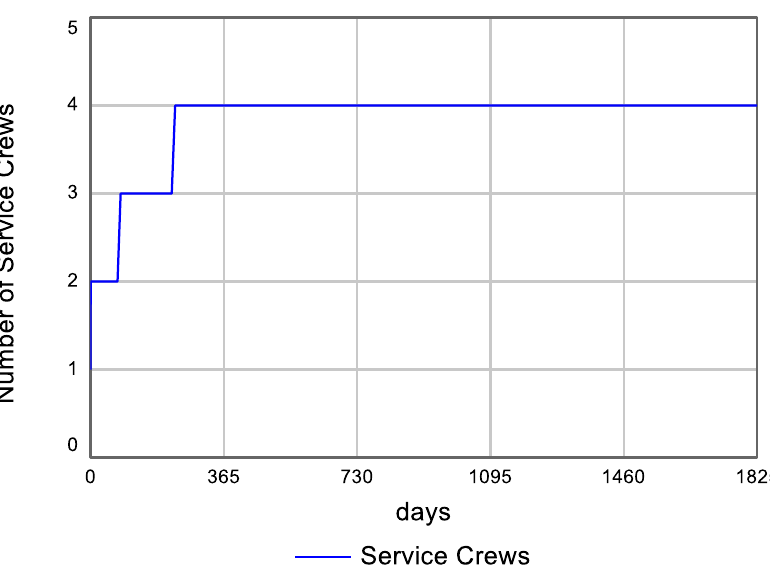
Figure 14. Variation of the number of service crews with time.